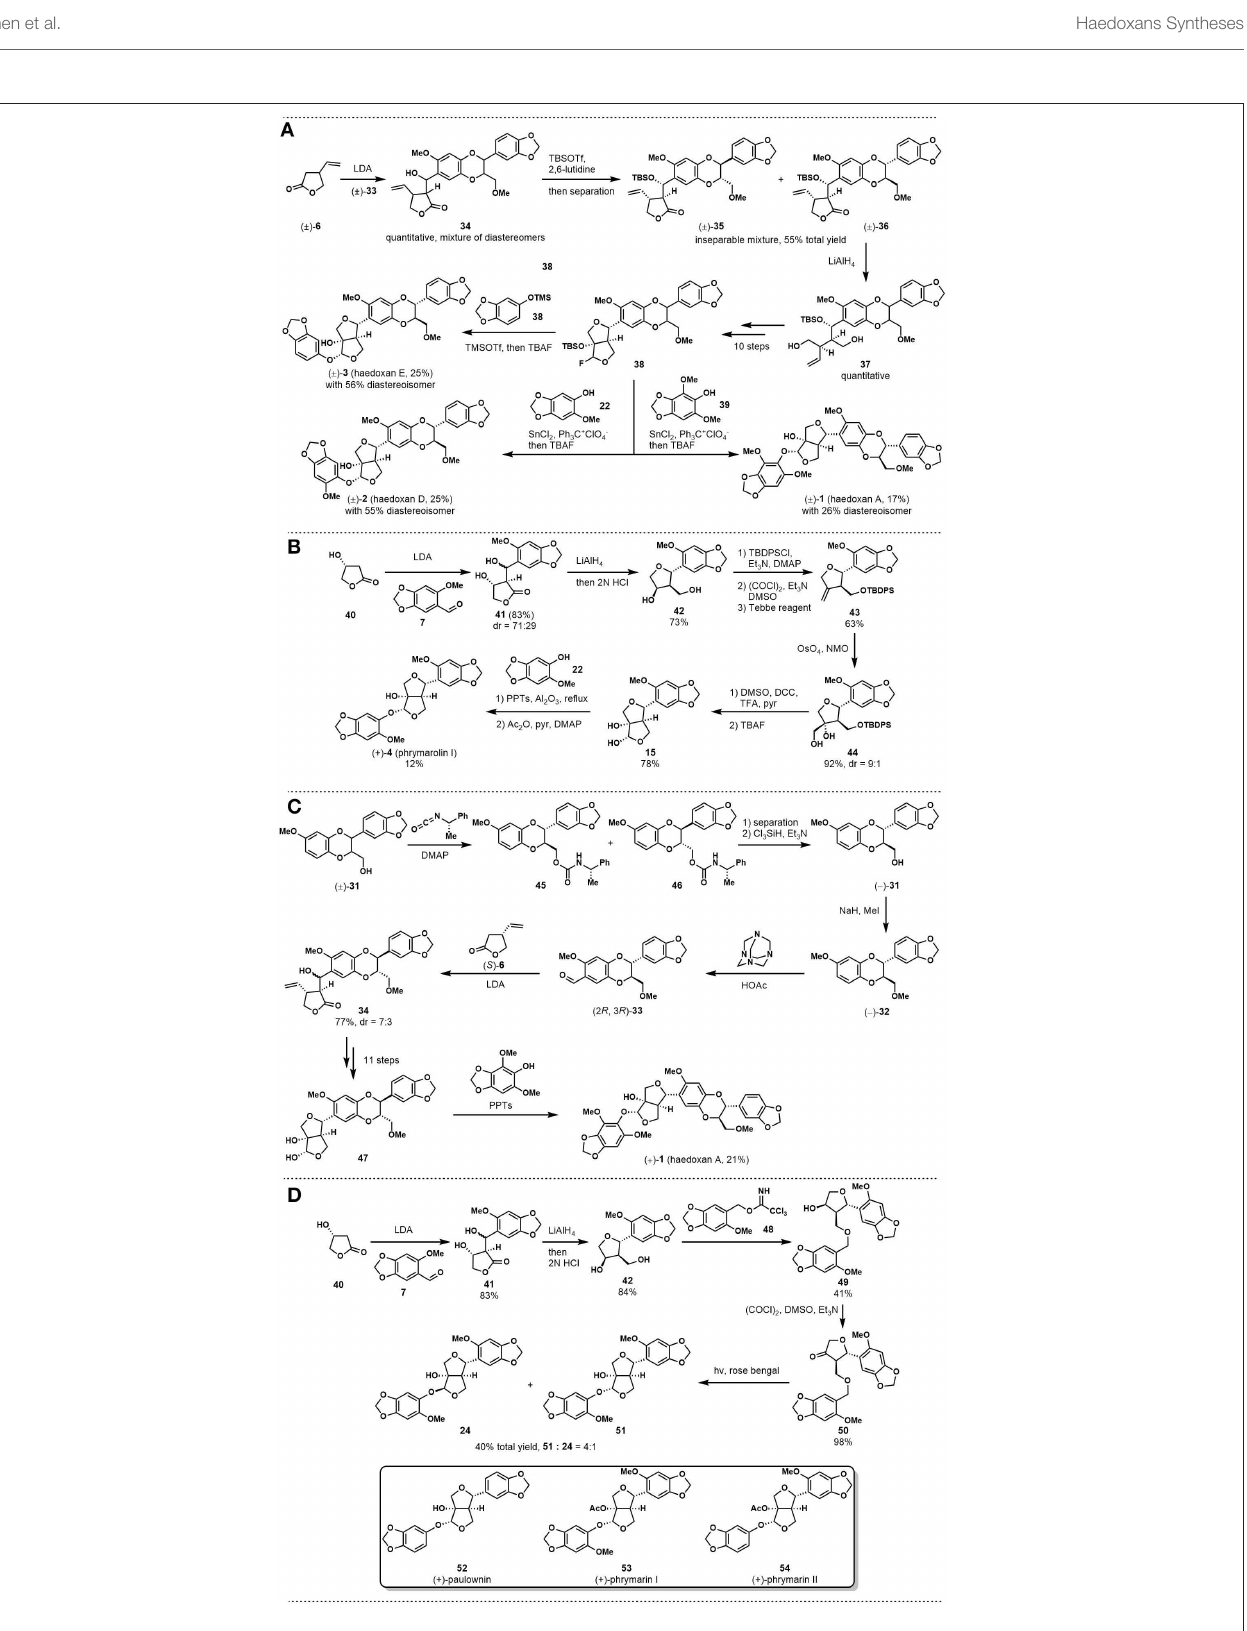
Frontiers in Chemistry |